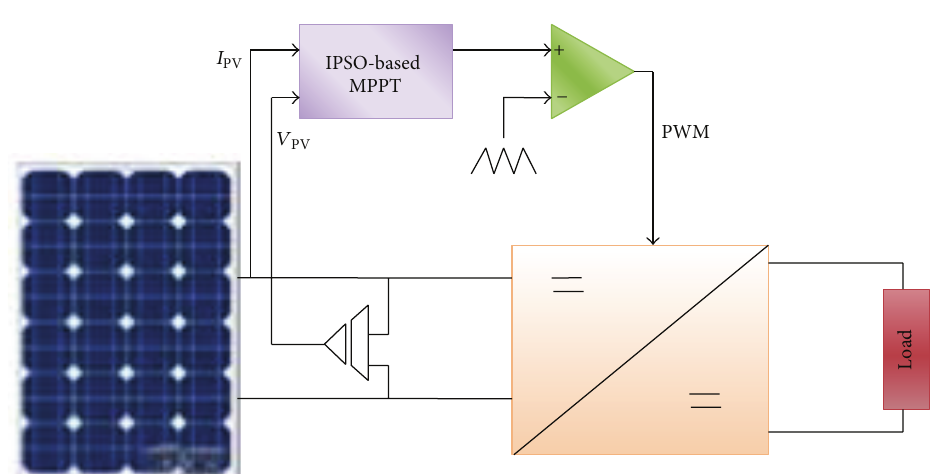
Figure 1: Photovoltaic System.